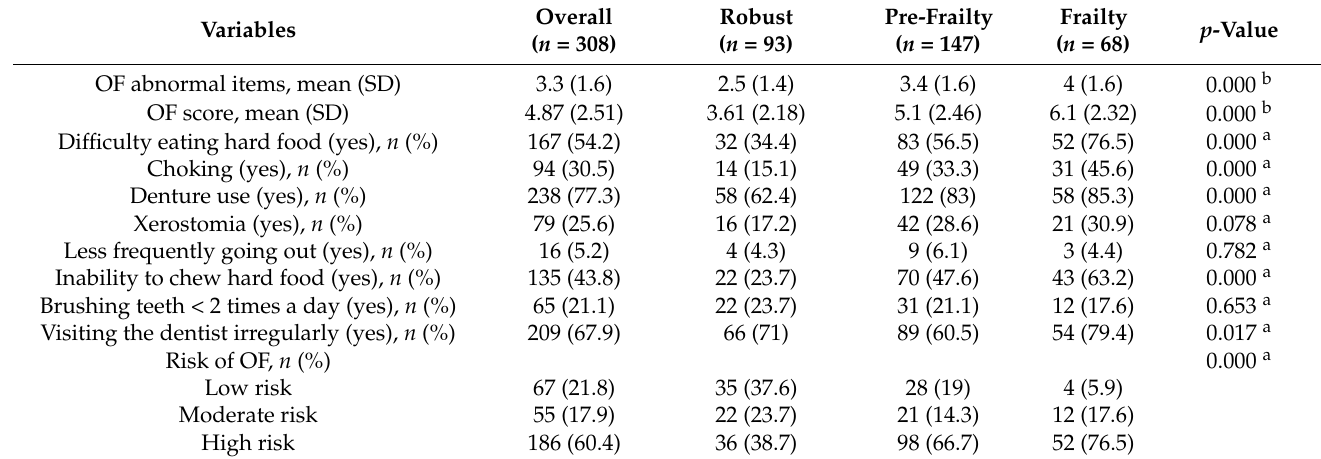
Table 2. OF score and subdomains for middle-old people with different physical frailty statuses.